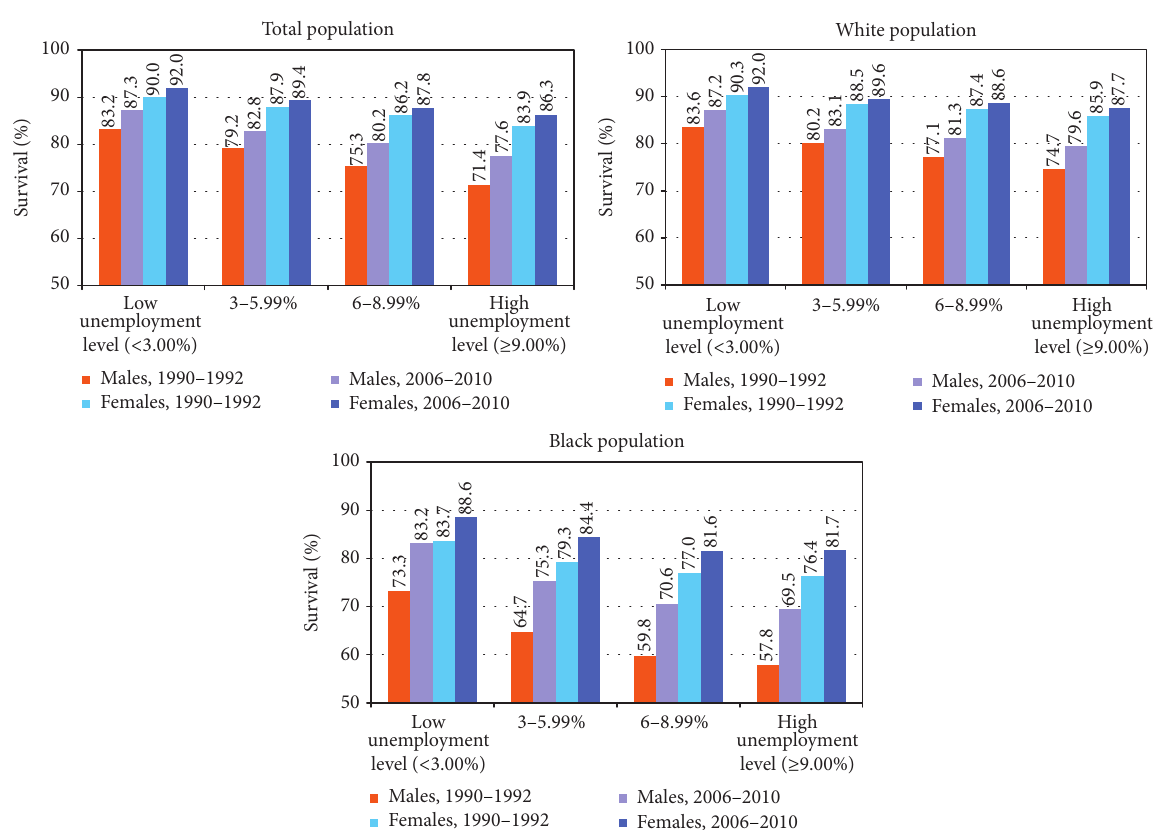
Figure 3: Conditional probability of survival between ages of 25 and 64 years by unemployment level, United States,